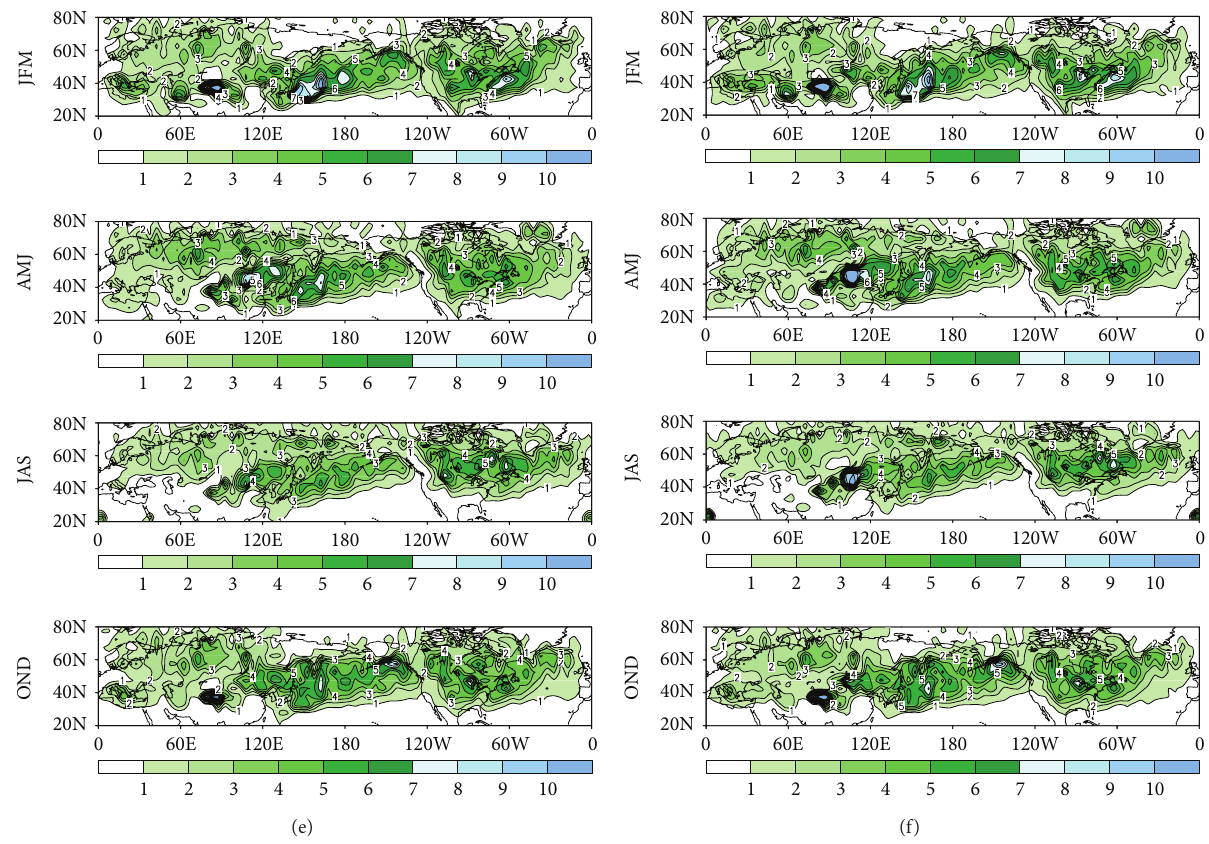
Figure 9: Cyclone track frequency climatology (shaded) for (a) NCEP1 5010 (JFM, AMJ, JAS, OND), (b) like (a) but for NCEP1 5801, and (c) like (a) but for ERA40 5801. Units: number of storms per winter for a 5 ∘ × 5 ∘ box. Cyclone track frequency climatology (shaded) for (d) like (a) but for Re27910, (e) like (a) but for NCEP1 7910, and (f) like (a) but for NCEP1 5078. Units: number of storms per winter for a 5 ∘ × 5 ∘